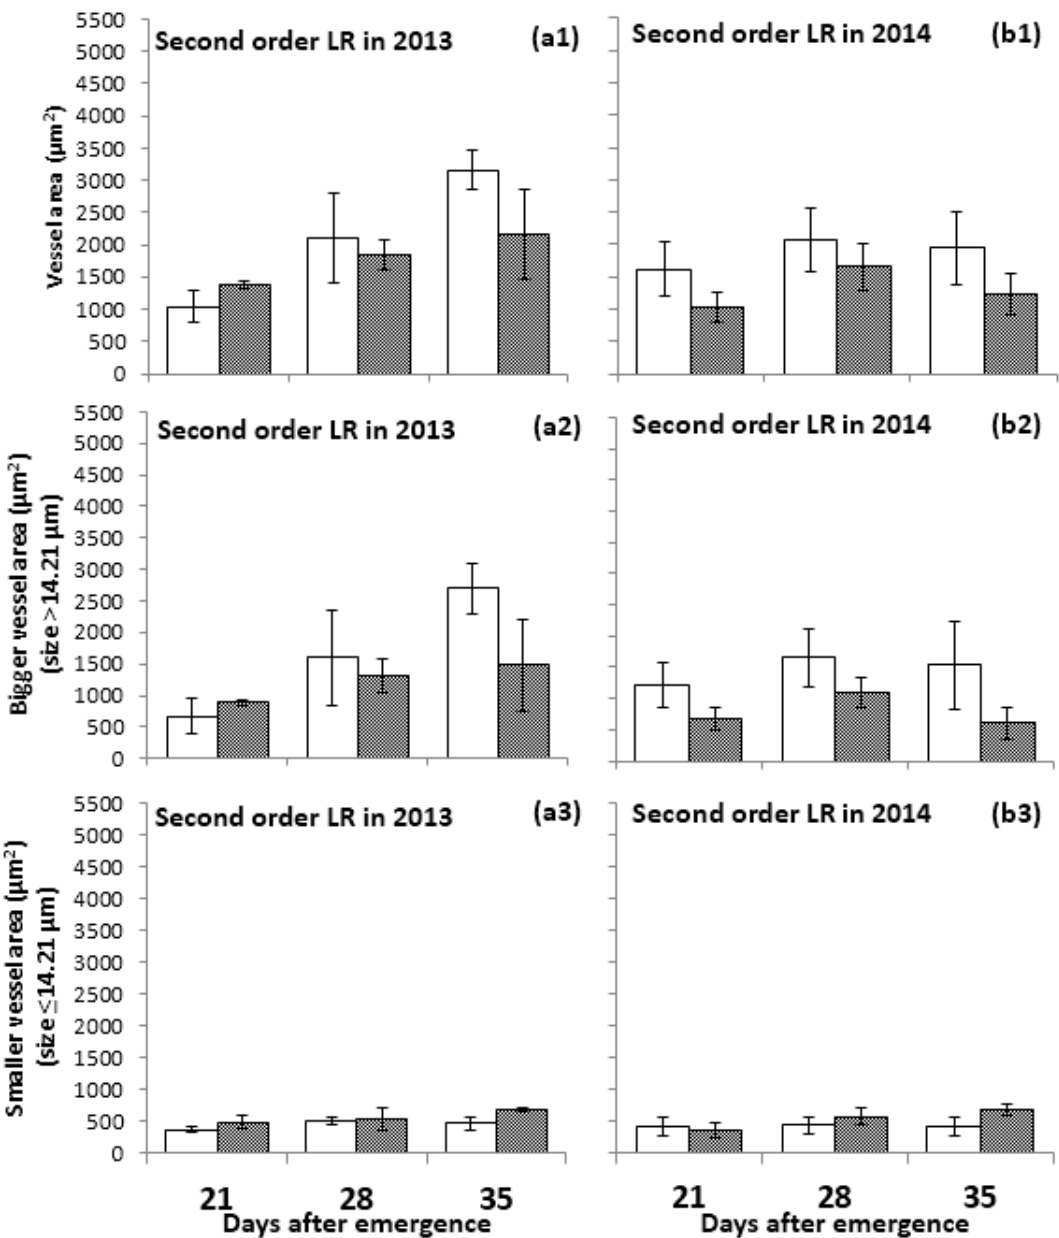
Figure 11. Vessel area ( a1 , b1 ), bigger vessel area ( a2 , b2 ) and smaller vessel area ( a3 , b3 ) of second order lateral roots of peanut at 21, 28 and 35 DAE in 2013 ( a ) and in 2014 ( b ); Significant at * p ≤ 0.05, non-stress treatments ( □ ) and stress treatments ( ■ ).